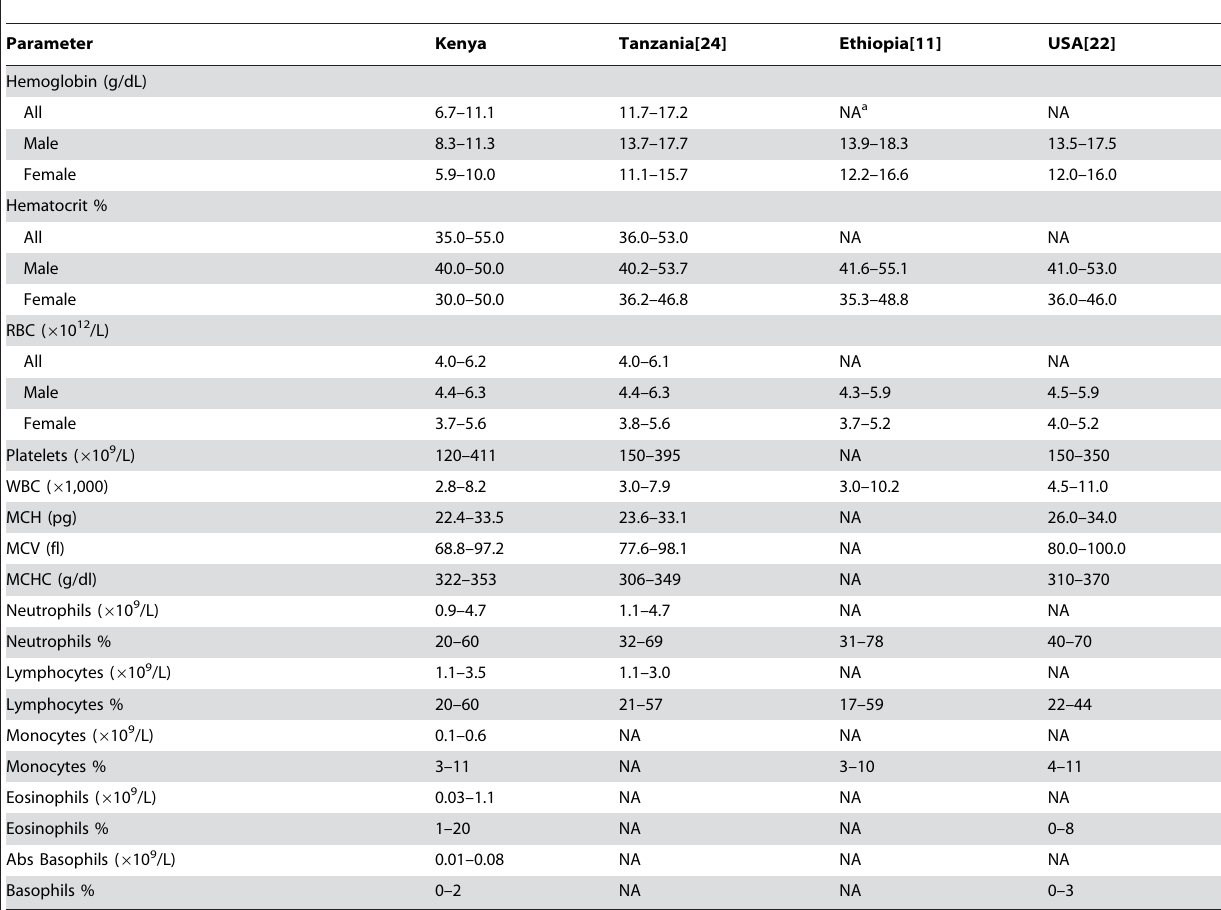
Table 5. Hematology reference ranges from Kericho, Kenya compared to other sources in Africa and the United States of America.